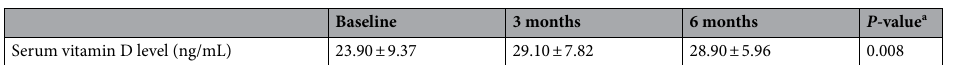
Baseline Serum vitamin D level Table 5. Changes in serum vitamin D level after treatment (n = 31). Data are presented as mean ± SD. By post hoc analysis using Bonferroni, there was a significant difference between baseline and 3 months ( P = 0.020). However, no difference was found between baseline and 6 months ( P = 0.077) and between 3 and 6 months ( P = 1.000). a By repeated measures analysis of variance.